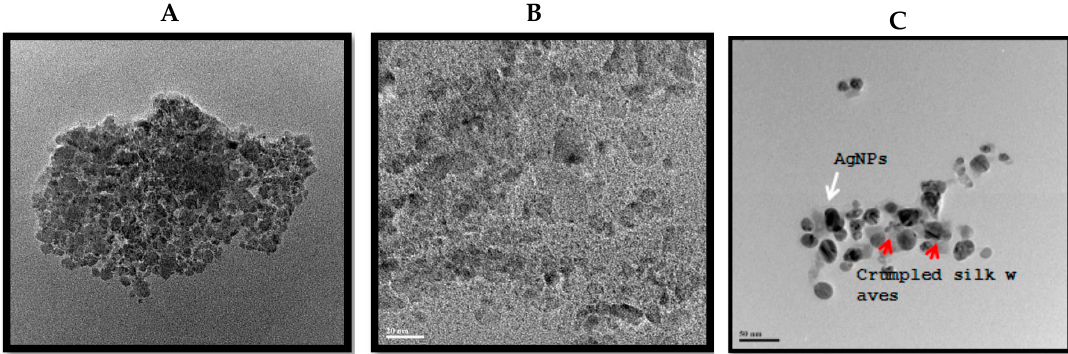
Figure 8. TEM images of ( A ) GO, ( B ) rGO, and ( C ) rGO–Ag nanocomposite. TEM images of fields were used to measure GO, rGO, and rGO–Ag particle.